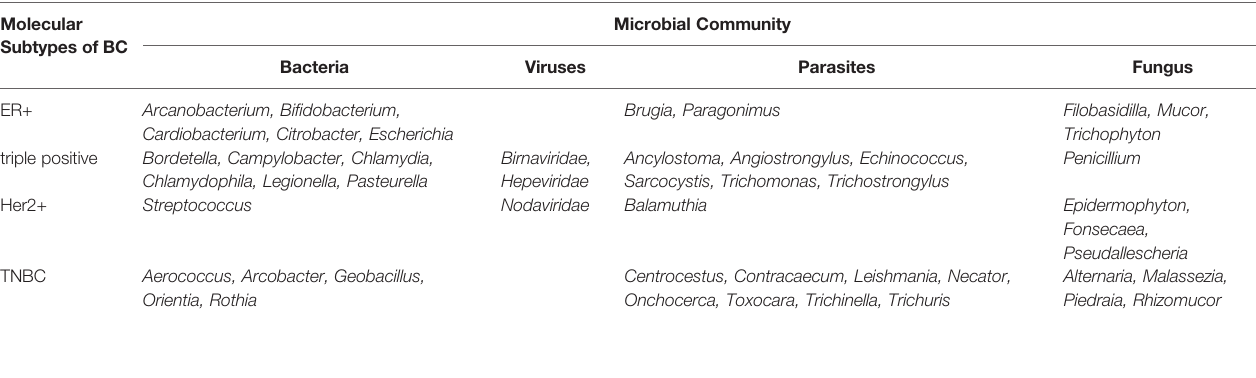
TABLE 2 | Microbial communities in different molecular subtypes of breast cancer. Molecular Subtypes of